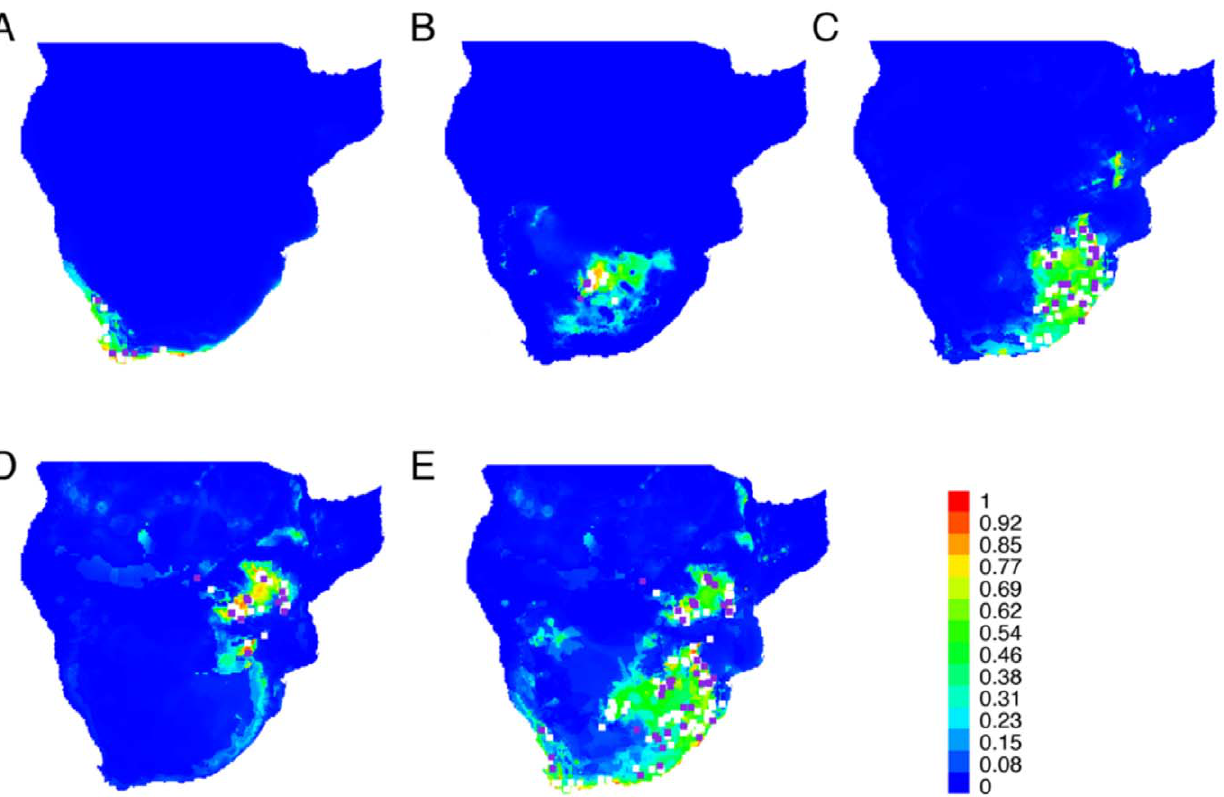
Figure 5. Ecological niche models (ENM). ENMs are based on occurrence records of four groups (see Fig. 2 tree) using current bioclimatic, altitude and ecoregions variables. A. Group 1, B. Group 3, C. Group 4, D. Group 5, E. all individuals. Shading shows probability of occurrence (i.e. habitat suitability) from low (blue) to optimal (red) conditions. Sampling locations used to build the ENM are shown as white squares and purple squares represent locations that were included in the training